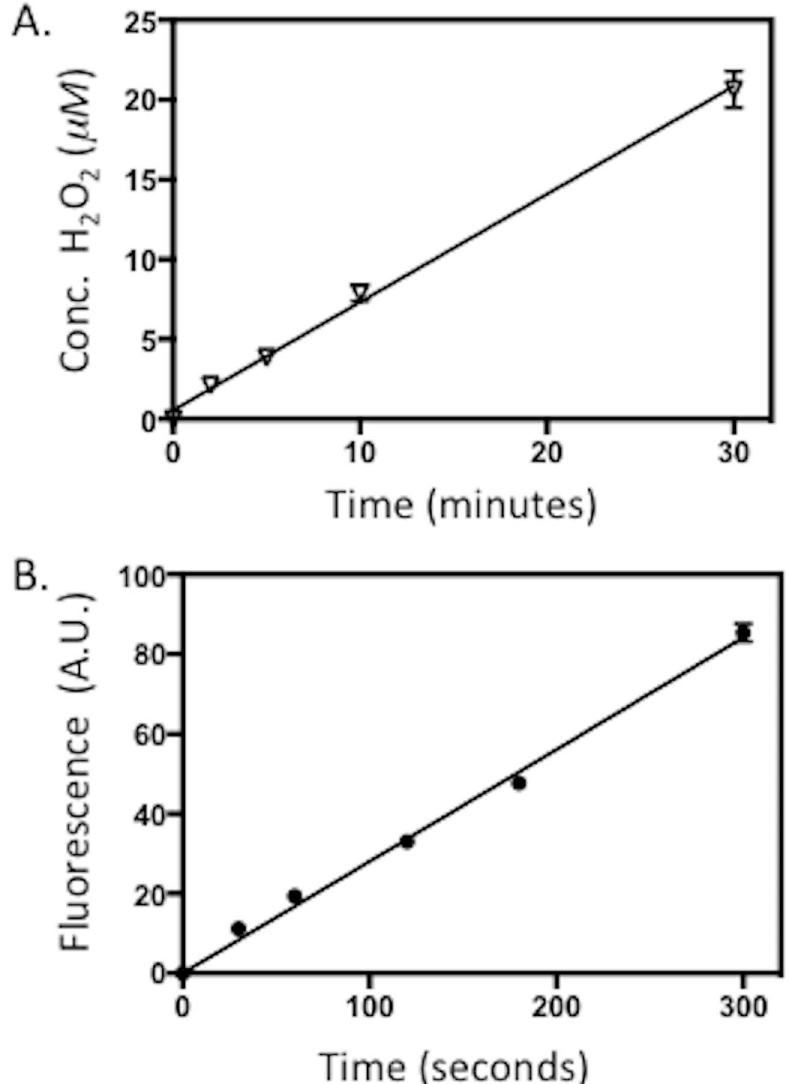
Fig 3. Formation of ROS by purified Drosophila Cryptochrome (DmCry). 30 μ M DmCry protein was illuminated at saturating blue light intensity for the indicatedtimes on ice. A. The concentration of H 2 O 2 released in the sample after illuminationwas determined by the Amplex Red fluorescence detection(see Methods). B. ROS formation in the course of illumination assayed by DCFH-DA fluorescence (ex: 490/ em:530) (see Methods). Error is SD of three